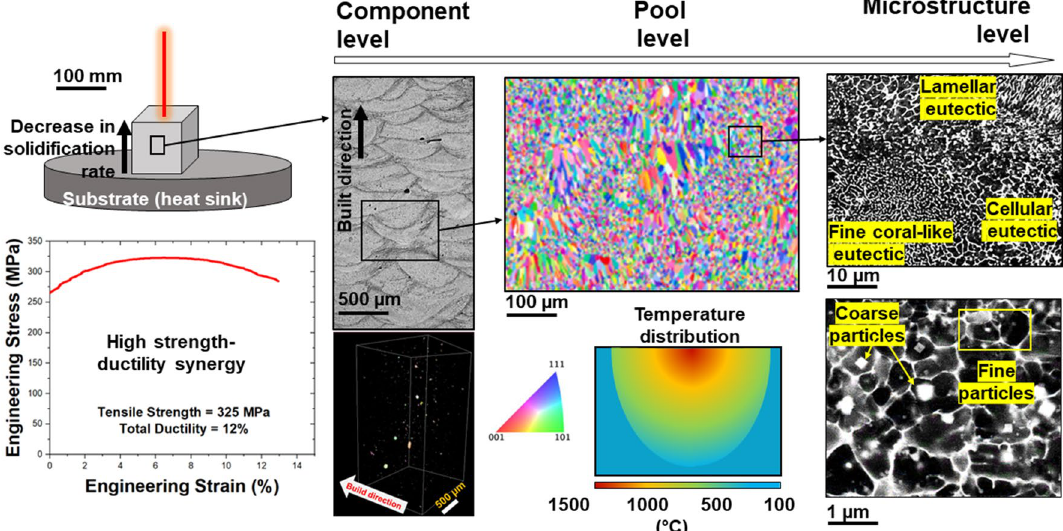
Figure 1. Multiple factors acting at different length scales contribute to the tensile stress–strain response of additively manufactured materials. Long-range thermal stresses and stochasticity of processing defects influence property at the macroscale. Gaussian heat distribution and microstructural heterogeneity impact mesoscopic properties at the pool level. At the microstructural level, heterogeneity in particle and eutectic segregation influences plasticity in micro-nano scales. The presented high-resolution nanoindentation map attempts to investigate properties at the pool and microstructural levels.